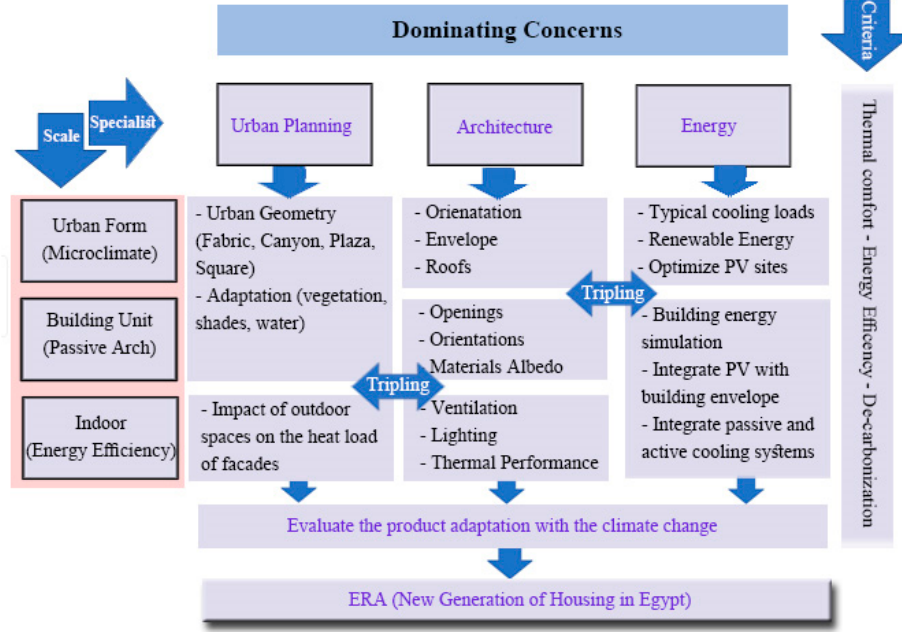
Figure 9. ERA dominating concerns that have to be evaluated by the Tripling Evaluation Methodology, TEM, to integrate the Urban-Building-Renewables dimensions,